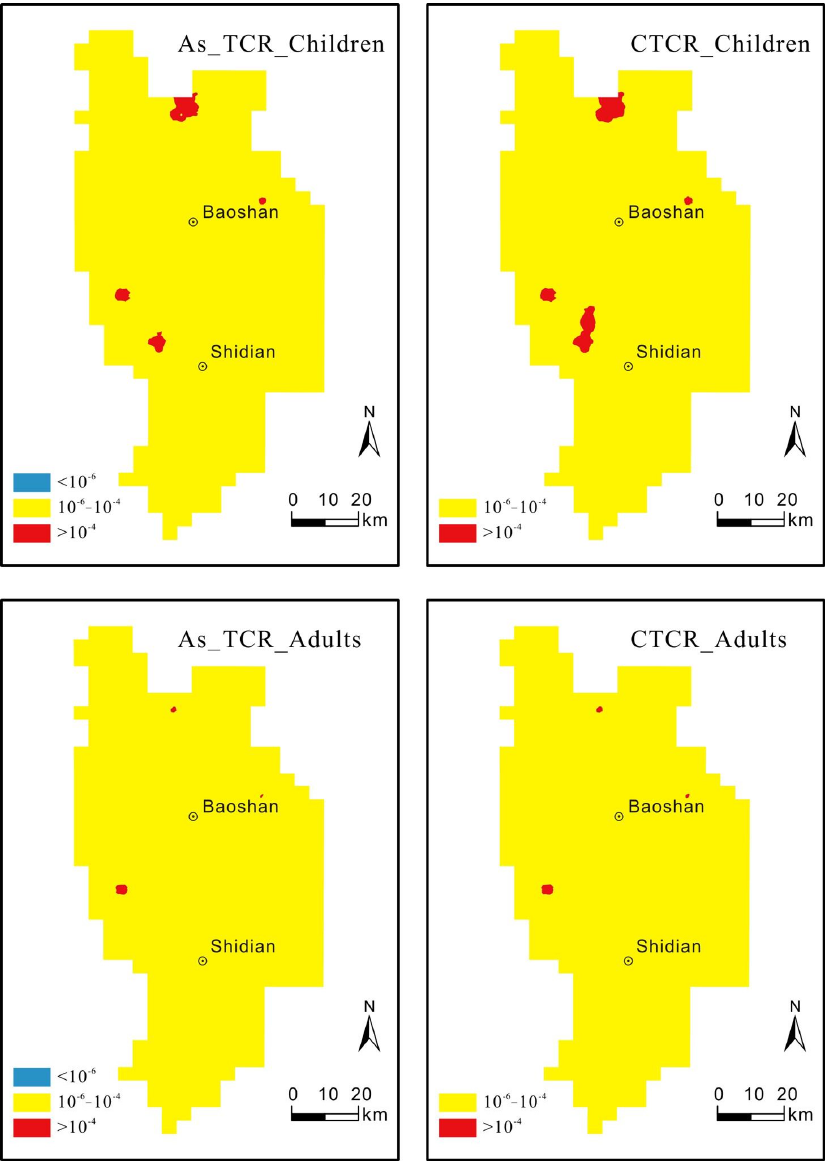
Figure 8. The distribution of counter maps of the carcinogenic risks (TCR) and cumulative carcino- genic risk (CTCR) determined by inverse distance-weighted (IDW) interpolation.